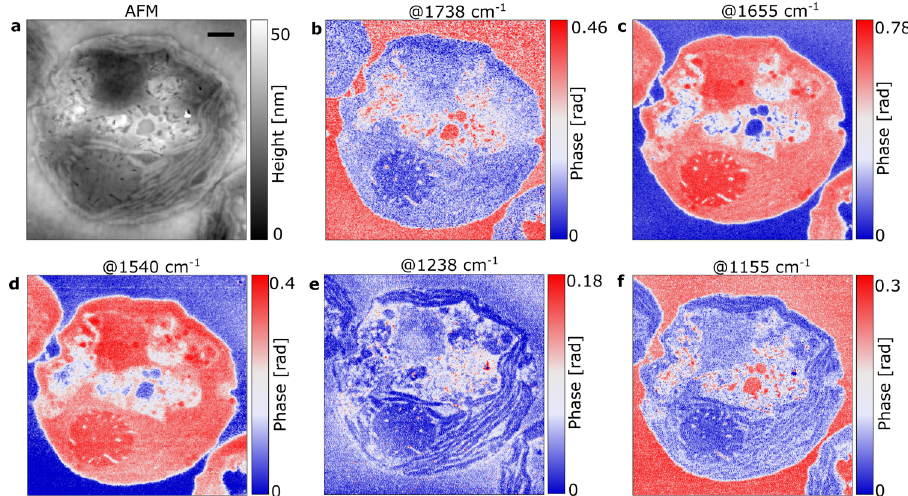
Fig. 3 sSNOM phase imaging of a C. reinhardtii cell. A single cellular cross section was visualized by AFM topography ( a ) and sSNOM phase imaging at several wavenumbers ( b – f ), with red indicating high and blue indicating low absorption of each respective wavenumber. Scale bar equals 1 µ